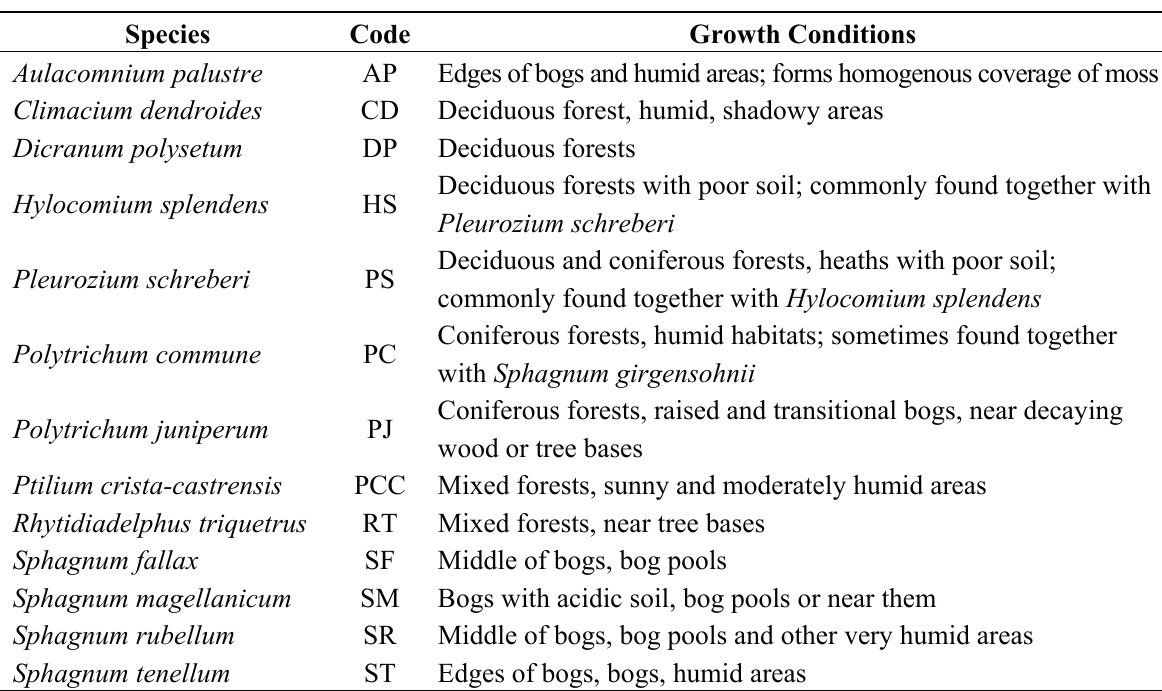
Table 1. Studied moss species with the corresponding codes and growth